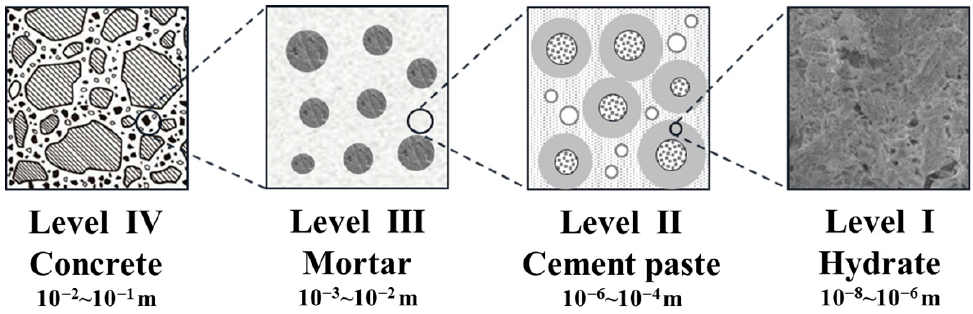
Figure 1. Multiscale homogenization scheme for concrete materials.